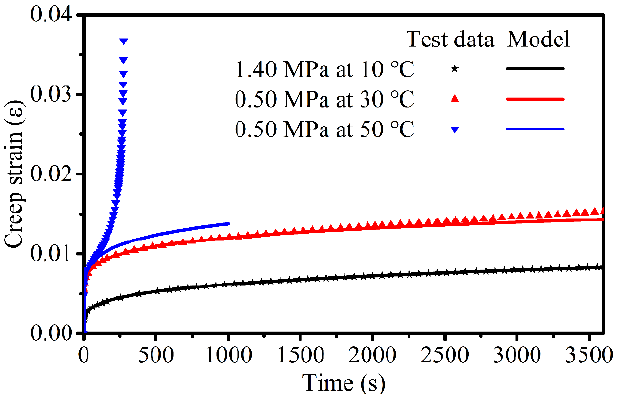
Figure 2. Consolidation effect and decelerating stage of the asphalt mixture: Abel model vs. test.